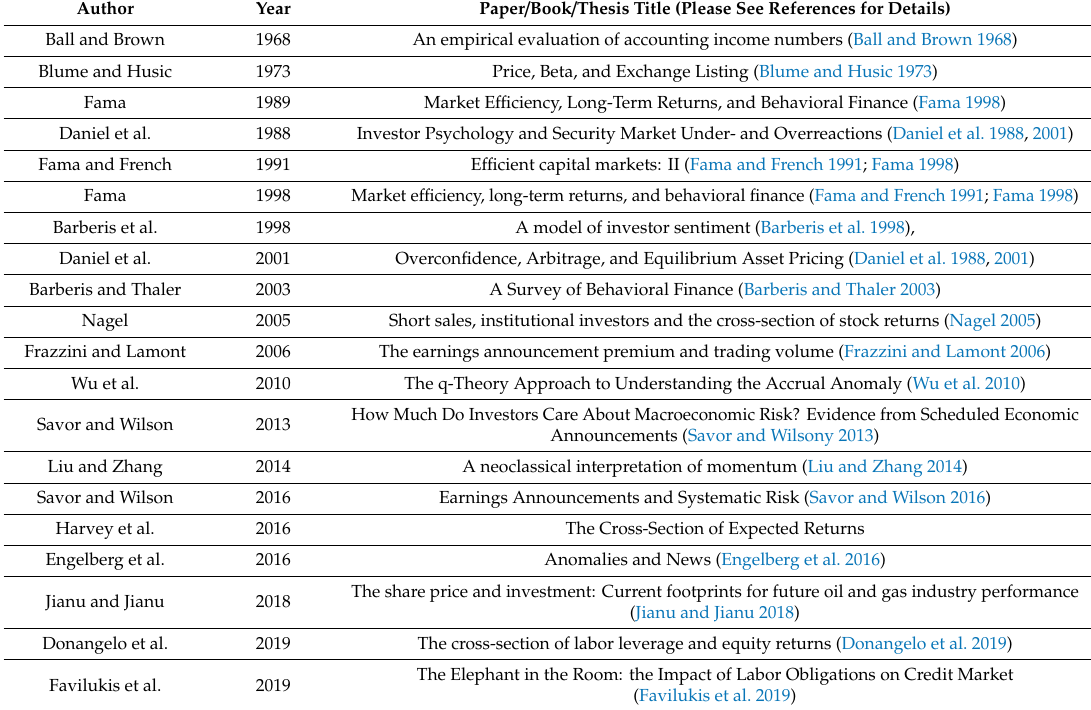
Table 5. Selected work on Reasons behind Cross Sectional Excess